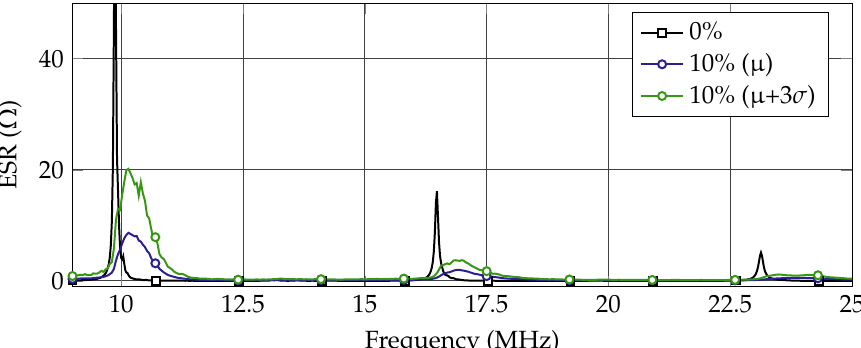
Figure 7. Comparison of extracted simulated ESR statistics from a modified 2D simulation model of 10% inclusions. The upper bound limit µ + 3 σ and mean µ of extracted ESR of 10% LDK inclusion configuration for 80 simulations is compared with no-inclusion model and a similar acoustics suppression is witnessed as compared to the 2D simulation model discussed